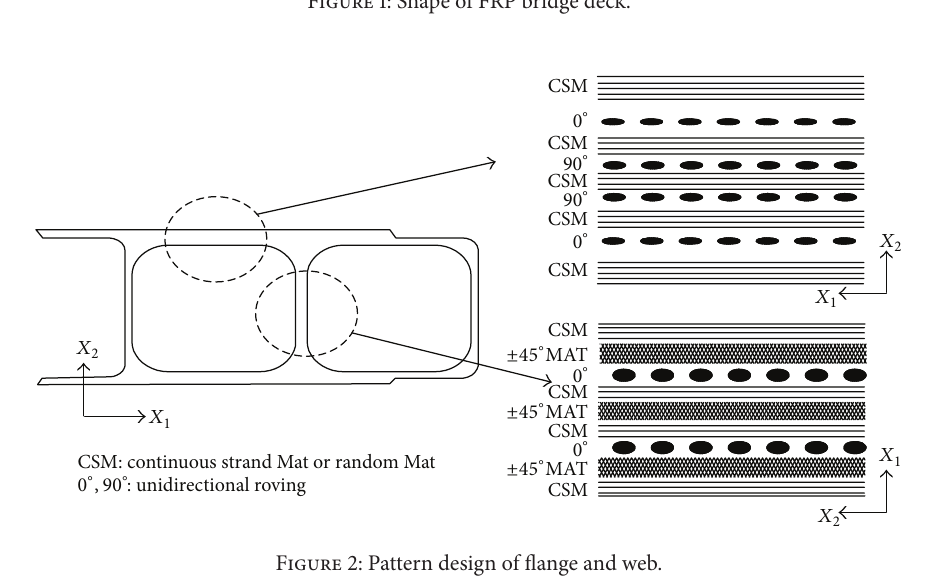
Figure 2: Pattern design of flange and web.